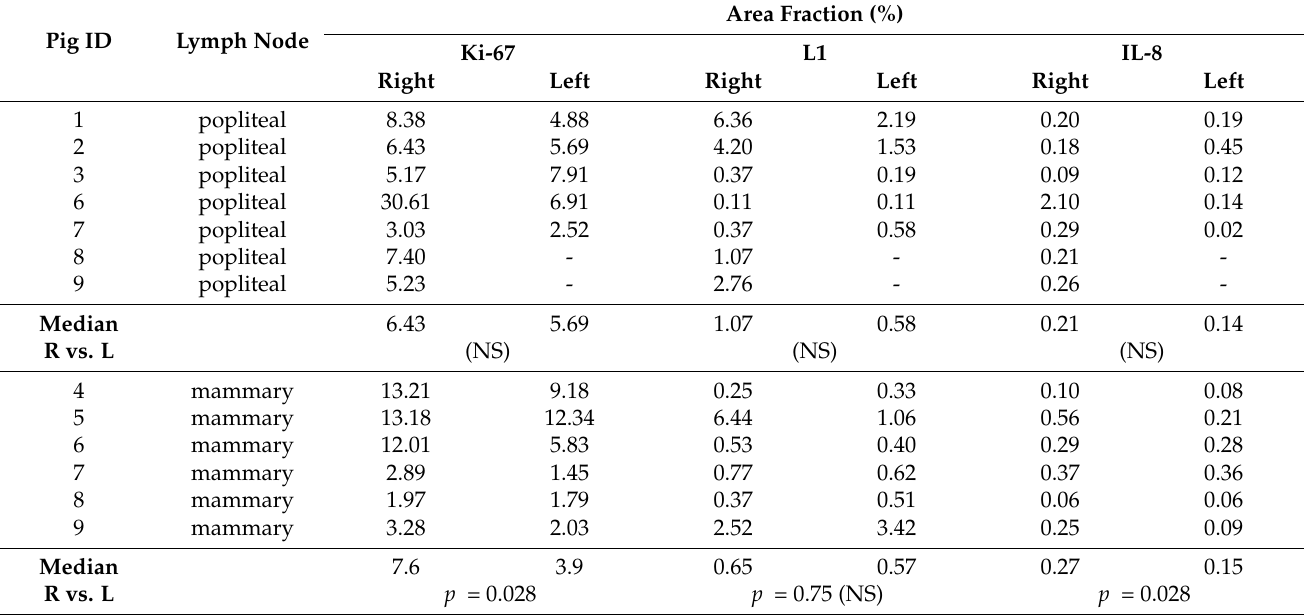
Figure 4. Area fractions. IHC stained lymph node tissue identifying Ki-67 (pig 3), L1 (pig 2), and IL-8 (pig 5) positive cells as indicated ( a , c , e ), and corresponding automatic threshold identification of positive cells with subsequent green labeling of the cells using Visiopharm Image Analysis Software ( b , d , f ). Scale bar = 50 µm. In general, the median area fractions and volumes of activated tissues were higher in lymph nodes draining the infected hind limb compared with those draining the Table 5. Area fractions of the mammary and the popliteal lymph non-infected limb, but this was not always statistically significant. For the popliteal lymph nodes, the area fractions showed no clear pattern, in some cases being highest in